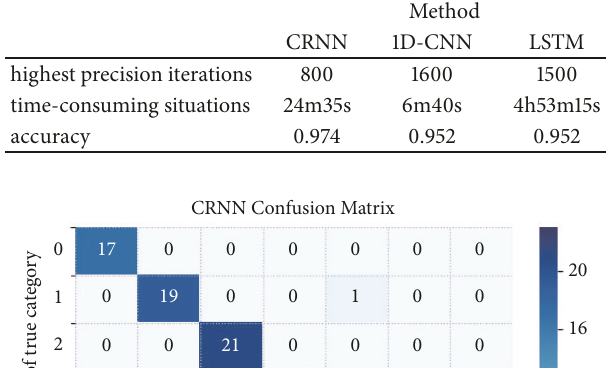
Figure 10: t-SNE visualization of the output layer of CRNN. The condition label of each fault is defined in Table